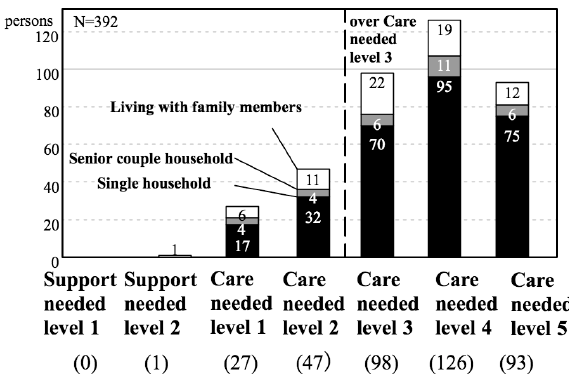
Figure 7. Number of persons aged 65 years or older in K City in nursing homes according to the severity of condition and household type.